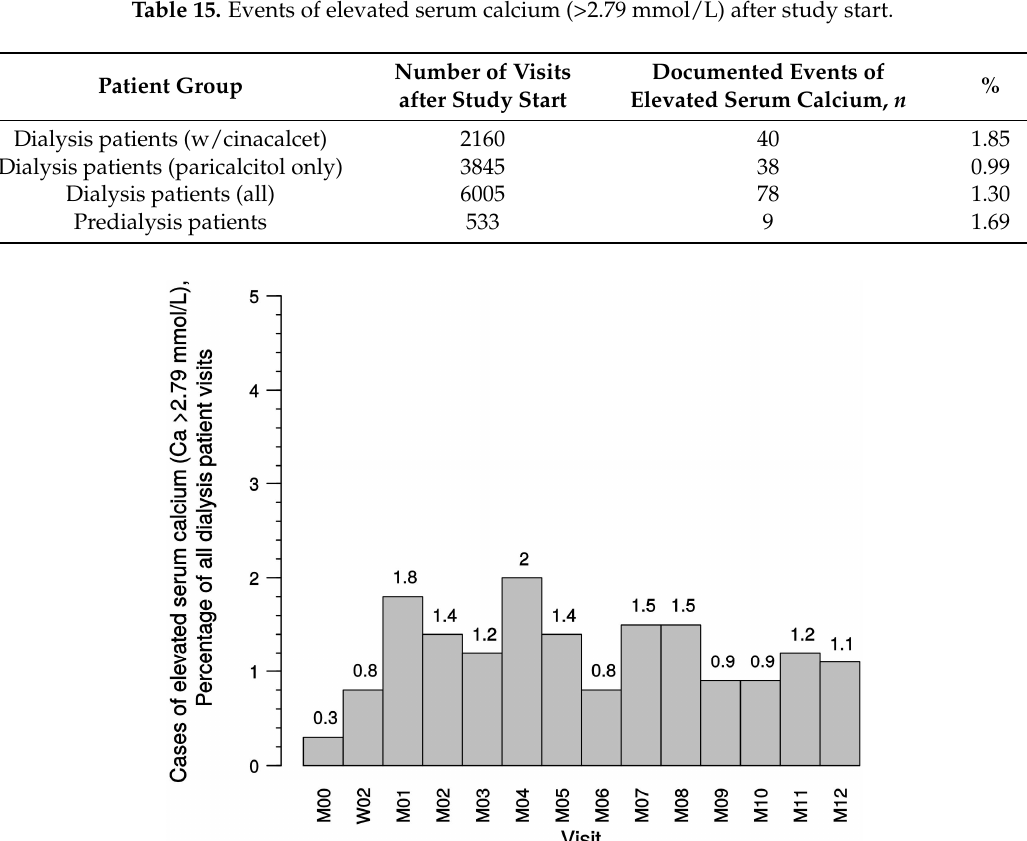
Figure 8. Percentages of elevated serum calcium (>2.79 mmol/L) in dialysis patients. Ca, calcium; M, month; W, week. month; W, Table 15. Events of elevated serum calcium (>2.79 mmol/L) after study start.